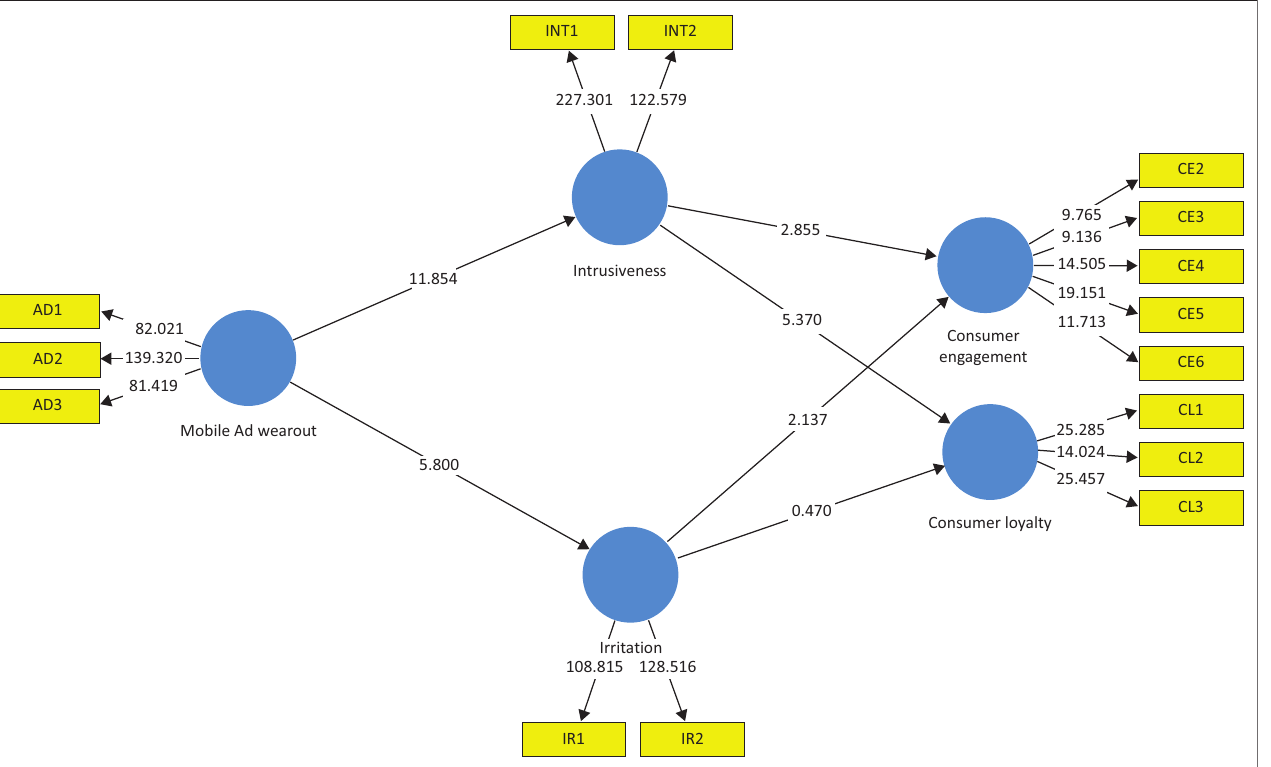
INT, intrusiveness; CL, consumer engagement; CE, consumer loyalty. FIGURE 2: T-statistics of the indicators and beta coefficients. TABLE 3: Divergent validity using Fornell–Larcker matrix. Variables